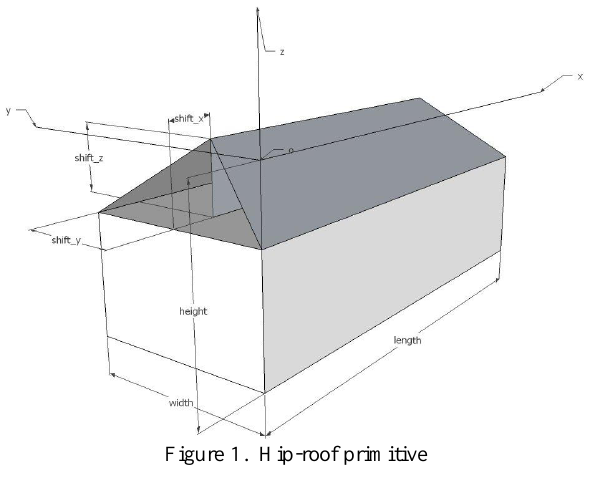
Figure 1. Hip-roof